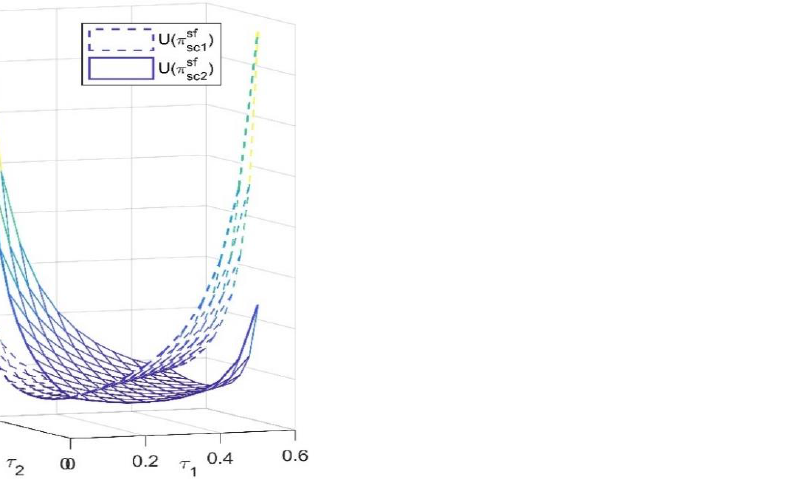
Figure 6. Changes in the total expected utility with the free-riding coefficient in the fourth case.